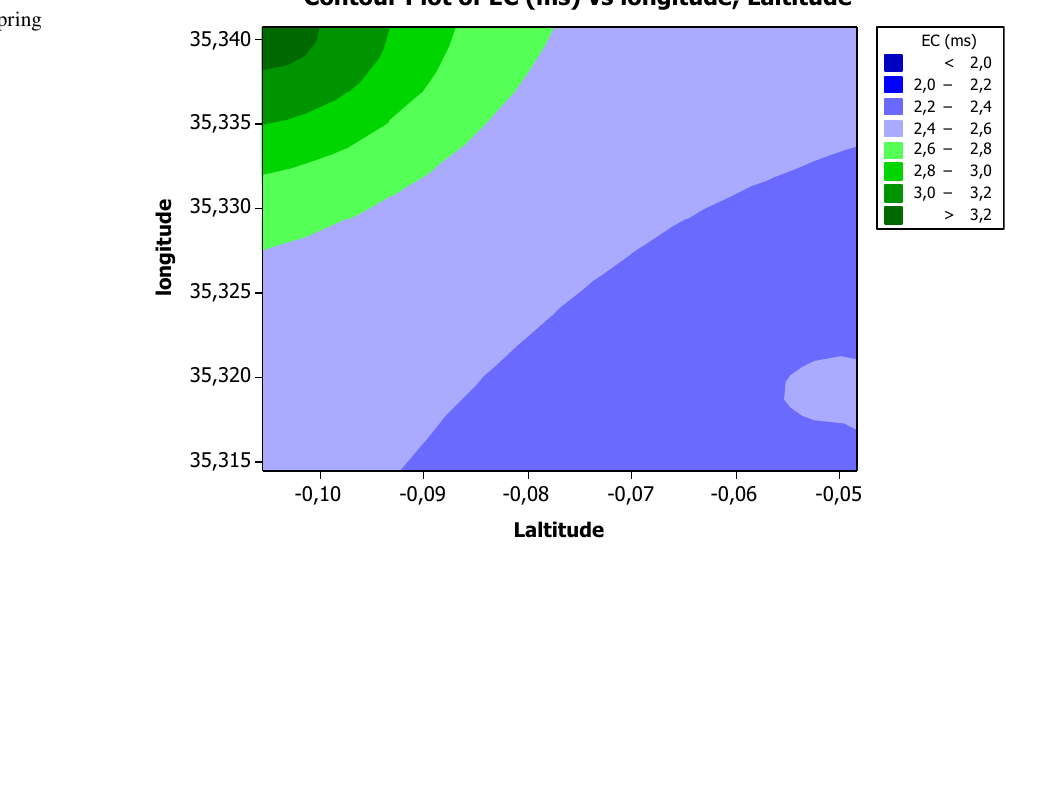
Contour Plot of EC (ms) vs longitude;